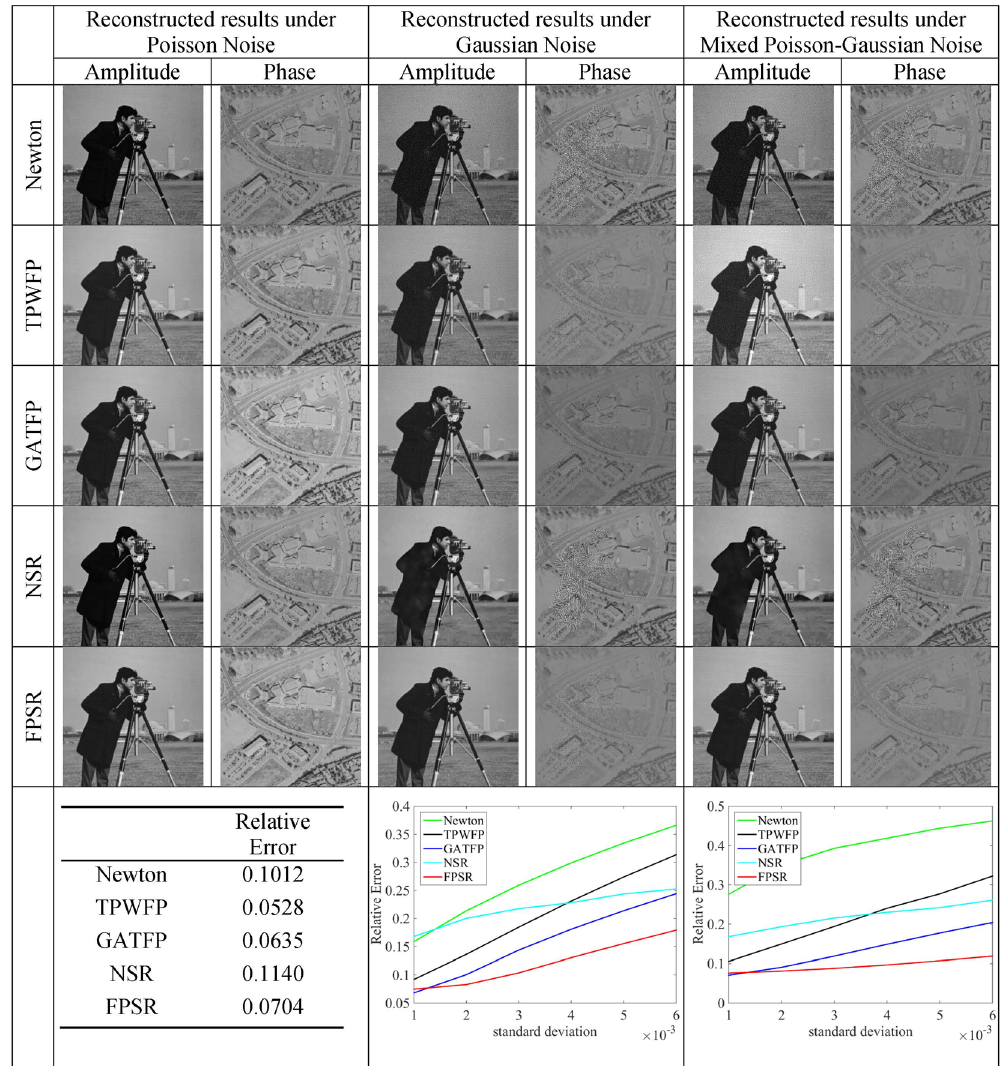
Figure 1. Reconstruction results with three types of noises (Poisson noise, Gaussian noise and mixed Poisson- Gaussian noise), using different algorithms (Newton method, TPWFP, GATFP, NSR and FPSR). This figure is not covered by the CC BY licence. Credits to copyright-holder of "cameraman" image: the Massachusetts Institute of Technology. All rights reserved, used with